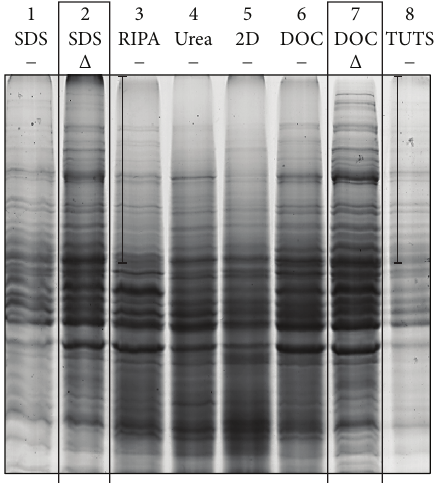
Figure 1: CBB stained gel from the 1D SDS-PAGE of proteins extracted from liver tumor samples using various extraction buffers. The loading concentration of each sample reflects the amount of proteins extracted from the liver samples before trypsin digestion. Larger number of protein bands would mean larger number of proteins extracted. Darker protein bands from each lane would mean a higher amount of proteins extracted. Black boxes indicate the two best extraction buffers and conditions in terms of number of protein bands and the intensity of the CBB stain. The highlighted regions for Lanes 2 and 7 show a larger number of visible bands compared to other lanes. Δ : heat.